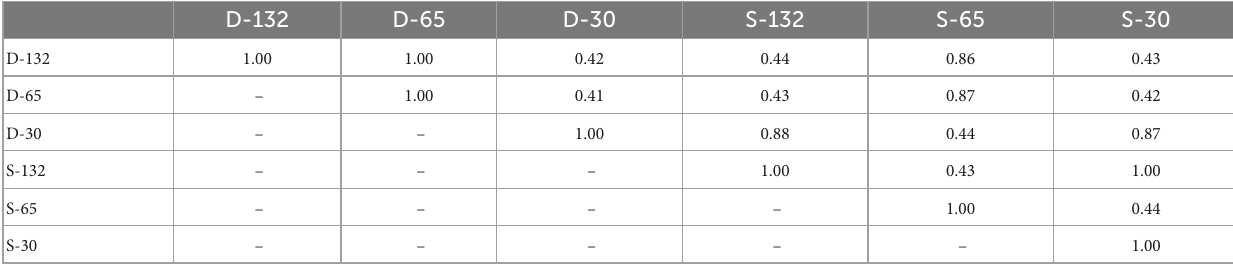
TABLE 5 Percent nucleic acid identities between pairs of transposon 125 (Tn125) sequence homologs retrieved from BA1A Meiothermus metagenome assembled genomes (MAGs).